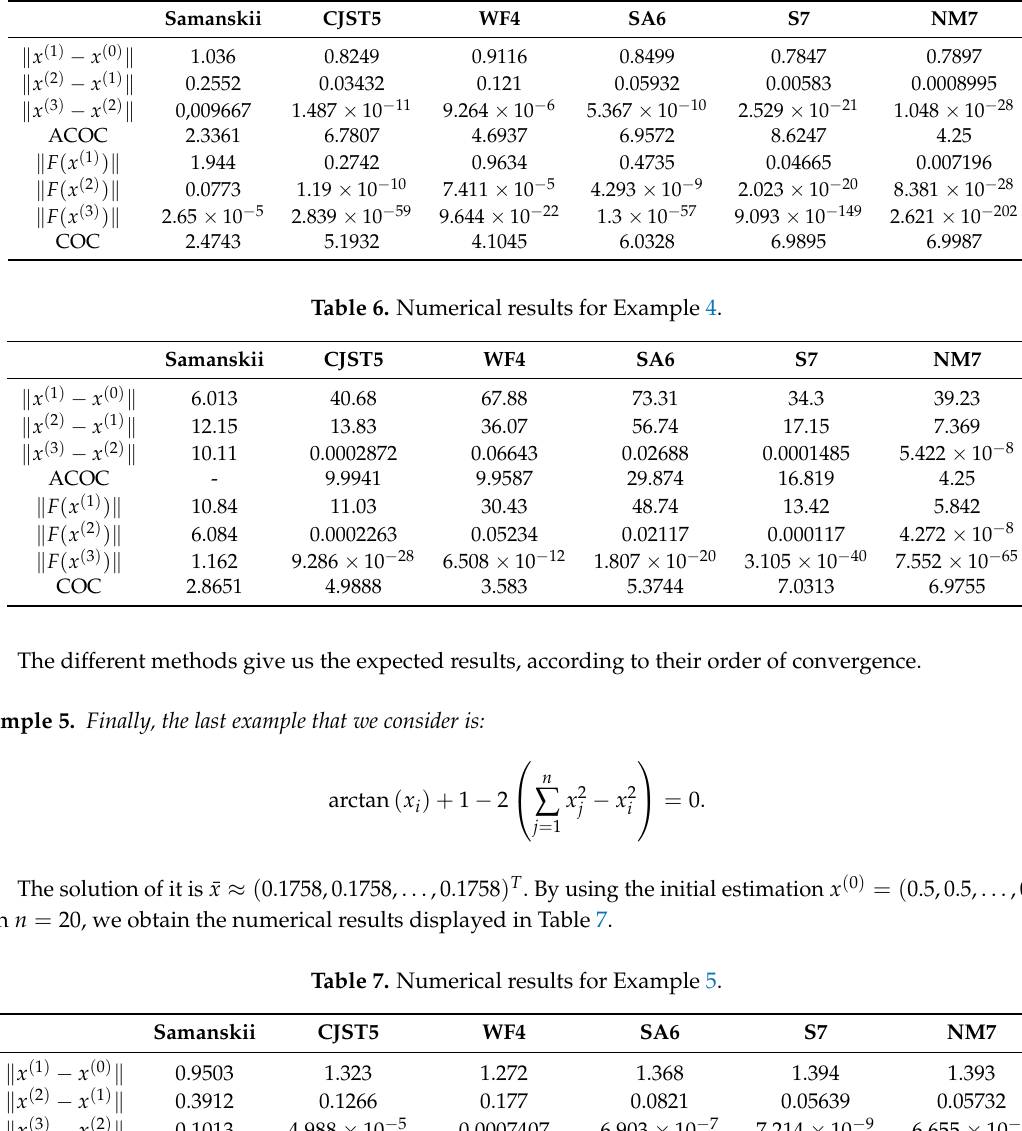
Table 5. Numerical results for Example 3.